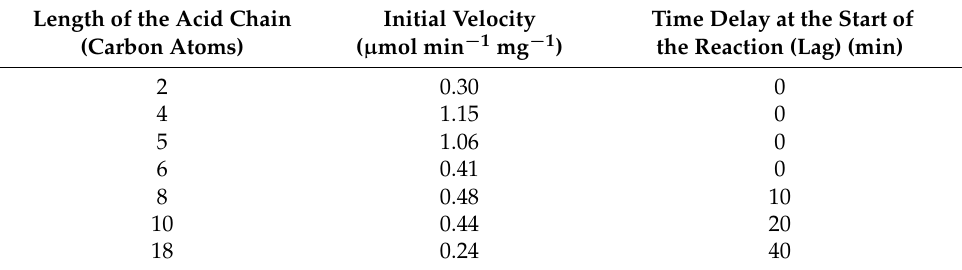
Table 2. Influence of the acid length on the initial rate of the esterification reaction. Note the delay time (lag) for the longest chain acids (C8, C10 and C18). Length of the Acid